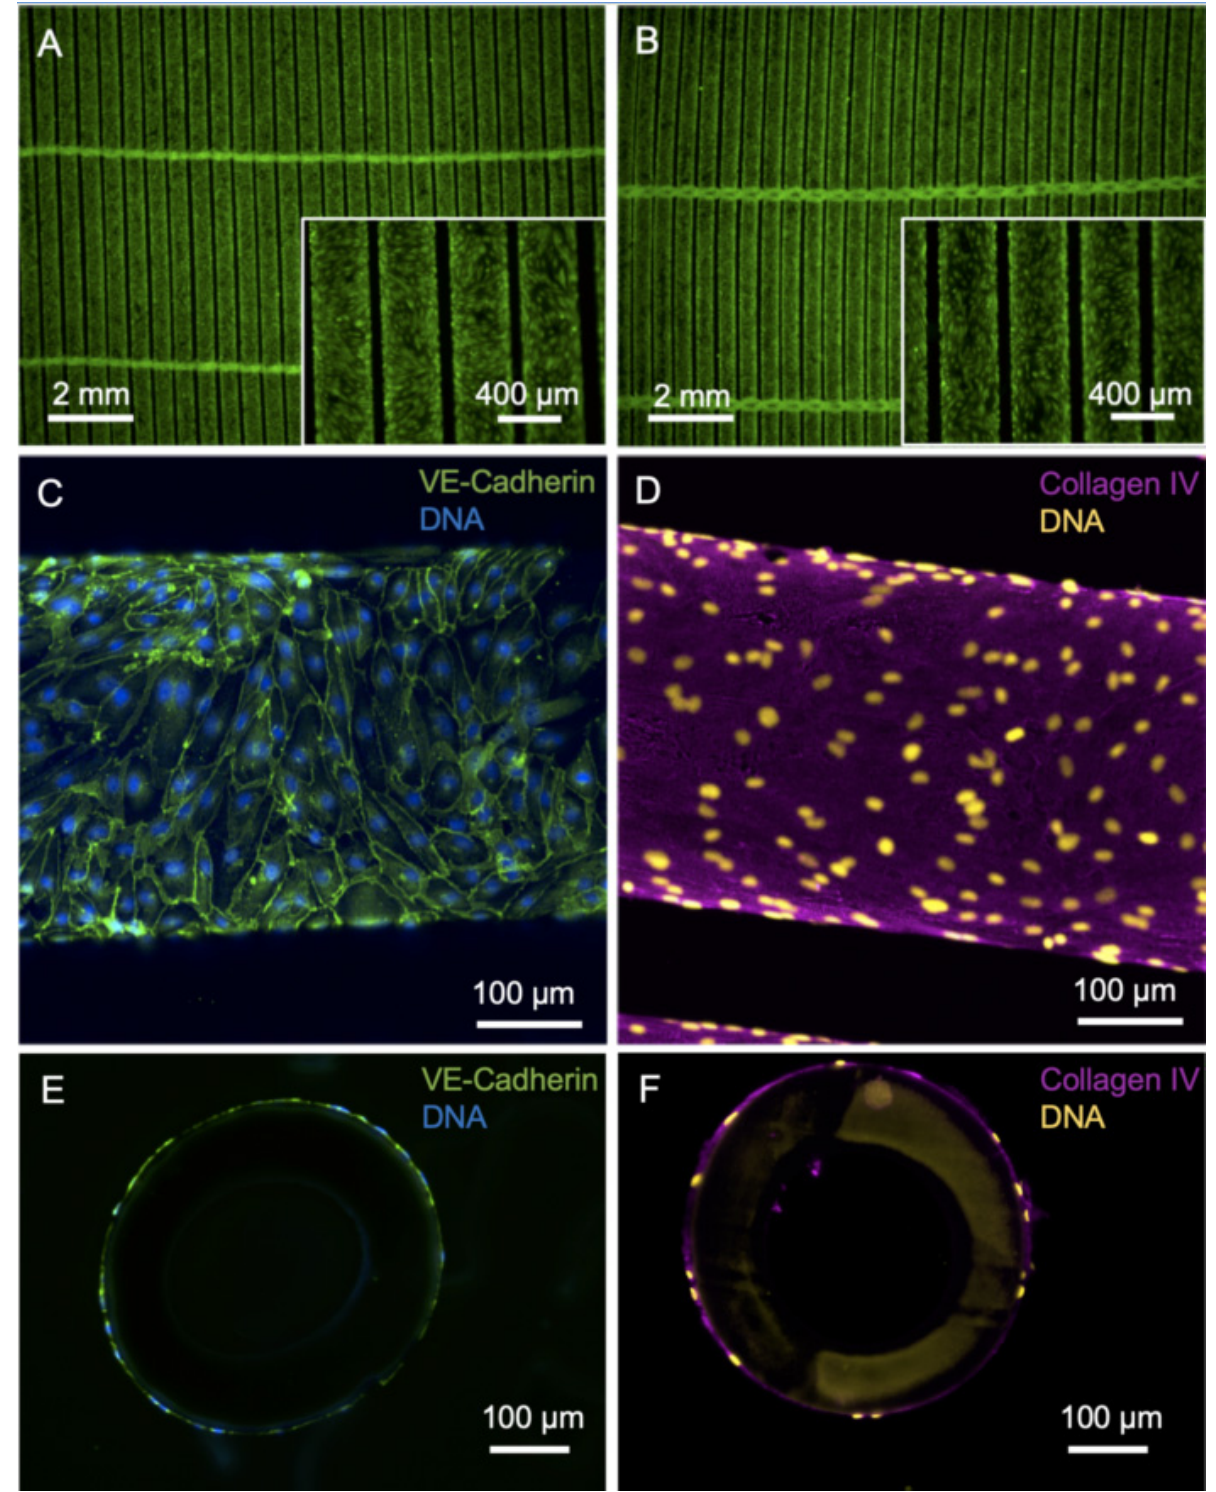
Figure 1. Imaging of HFM after endothelialization with iPSC-EC1. ( A , B ) Viable calcein-positive iPSC-ECs (green) seeded on fibronectin-coated HFM form a confluent monolayer around the individual fibers of the HFM. A: Top view, B: bottom view. ( C ) iPSC-ECs are interconnected via VE-cadherin (green). ( D ) Basal-lamina-like matrix envelops iPSC-EC-seeded hollow fibers, indicated by de novo synthesized collagen type-IV (magenta). ( E , F ) Nuclei counterstained with DAPI and presented in false colors (yellow).